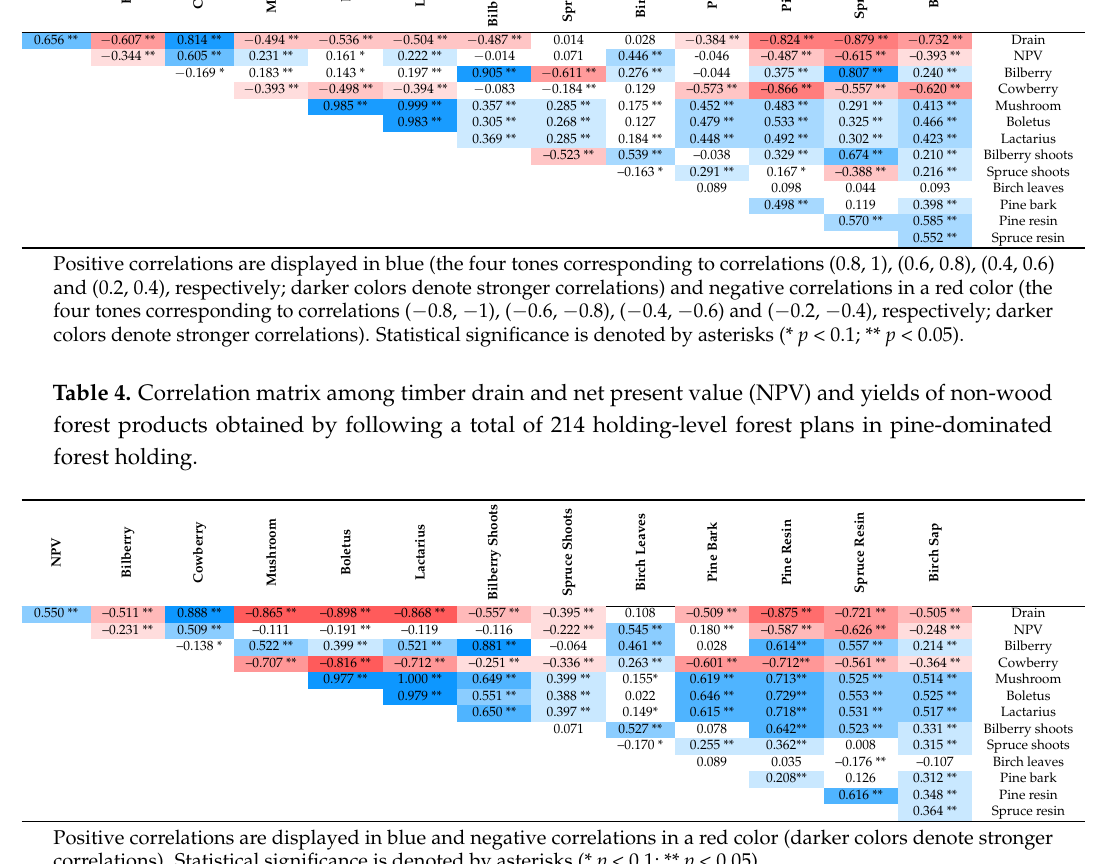
Positive correlations are displayed in blue and negative correlations in a red color (darker colors denote stronger correlations). Statistical significance is denoted by asterisks (* p < 0.1; ** p < 0.05). Timber drain only correlated positively with cowberry and birch leaf production (Tables 3 and